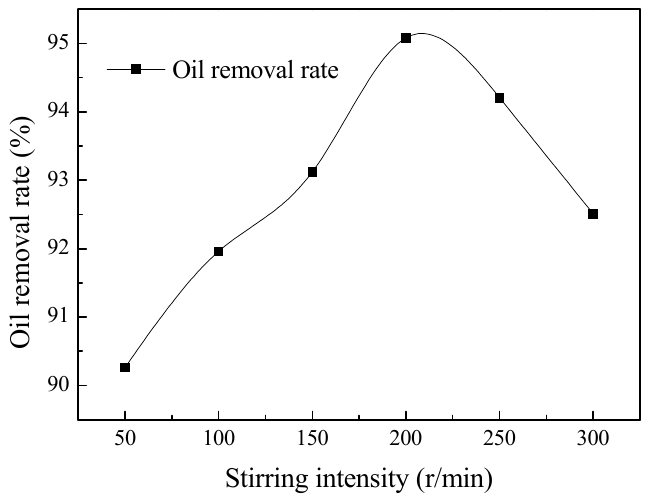
ff ect of stirring intensity on oil removal rate. Figure 7. Effect of stirring intensity on oil removal rate. Figure 7. E